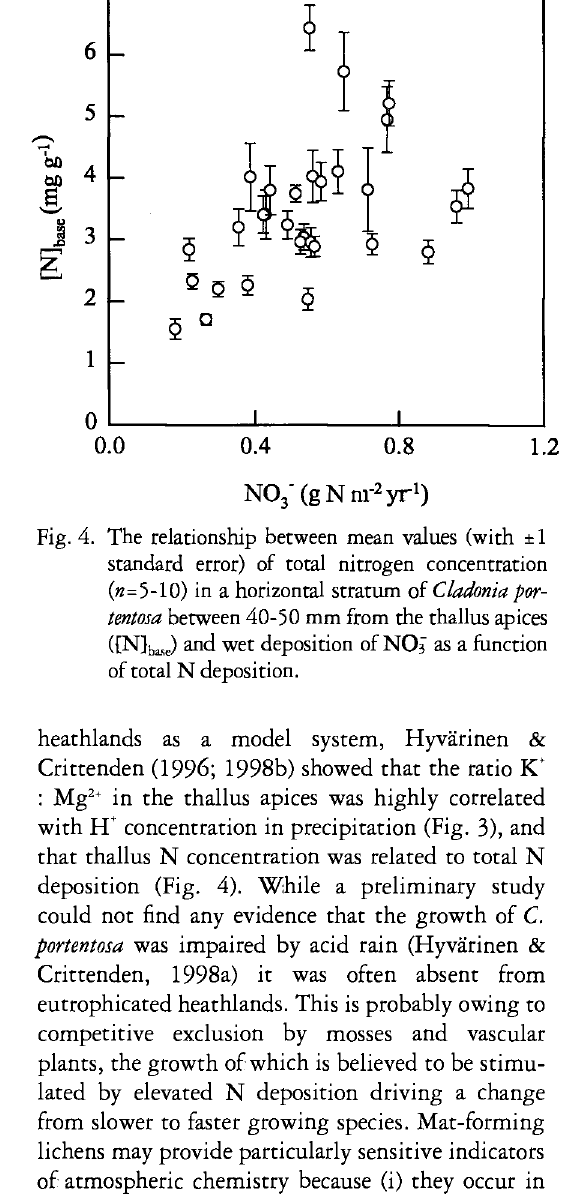
Fig. 5. Variation in mean values (with ±1 standatd error) of total nitrogen concentration (» = 18) in the api cal 5 mm of Cladonia stellaris along a 240 km transect in the Usa River catchment, notthem Russia. The transect extends from Vangyr (lat 64°14'N, long 59°12'E) in the boreal